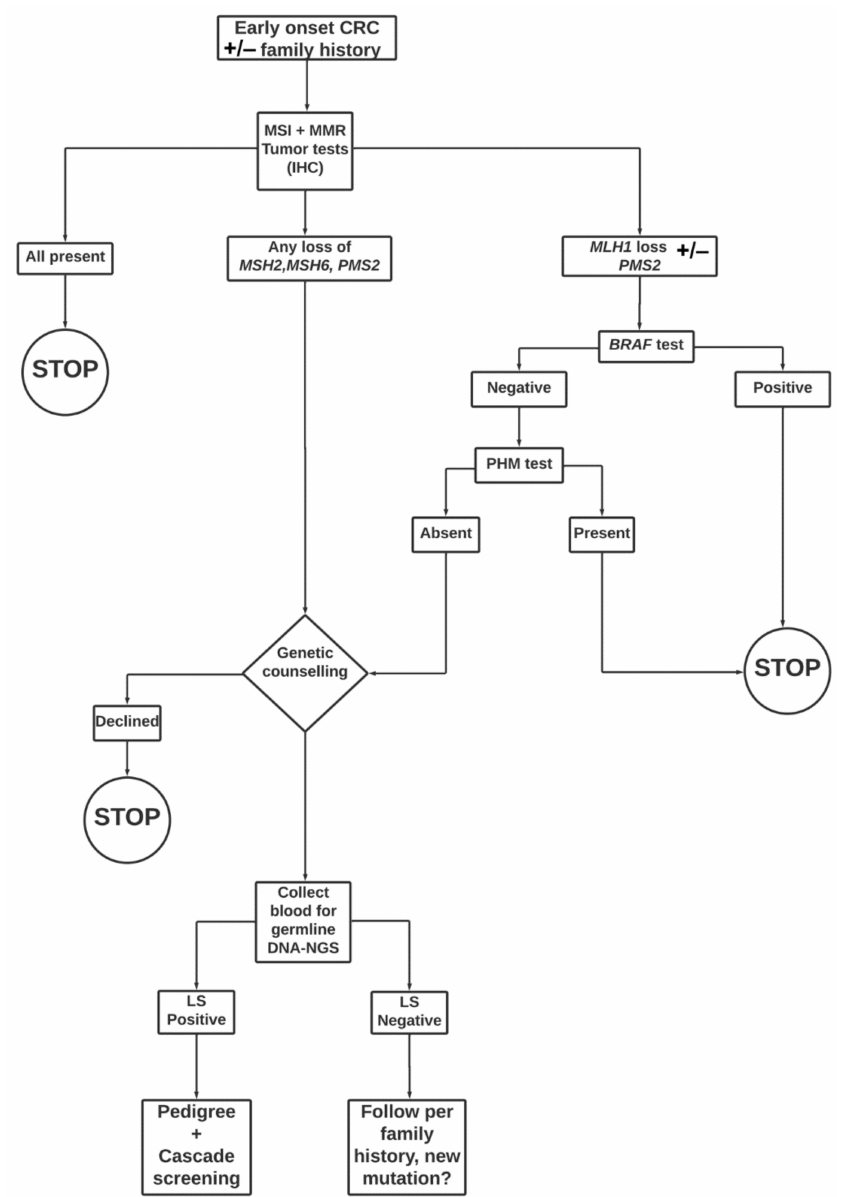
Figure 1. Workflow illustrating the process of genetic diagnosis of LS. A patient presents with early-onset CRC (age equal to/below 60 years). This presentation alone or in combination with other findings (family history, clinical and pathologic features of the tumor) raises suspicion that LS may be present. The tumor is examined for evidence of MSI (Bethesda marker), or lack of MMR protein expression (using IHC) [34,35]. If these findings are conclusive, they are supplemented by germline DNA mutation testing using